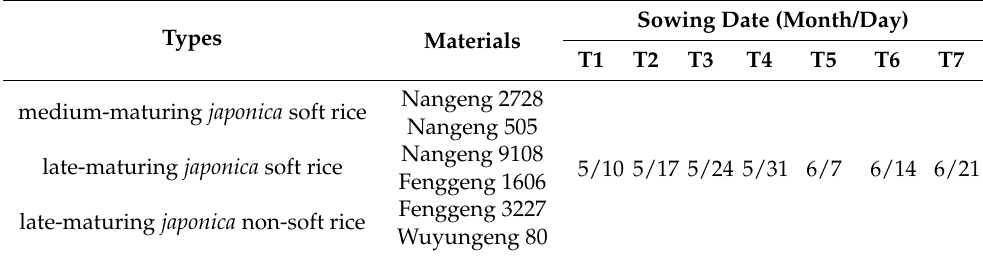
Table 1. The rice varieties and sowing